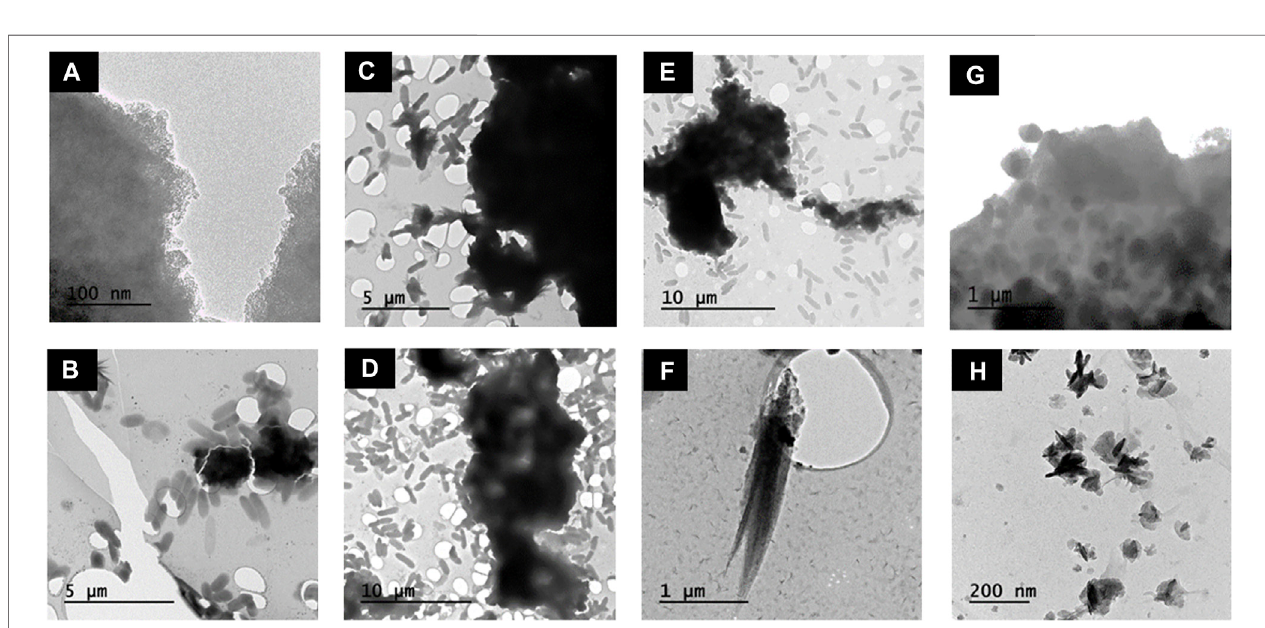
FIGURE 3 | TEM images of Co-doped ferrihydrite suspension associated with G. sulfurreducens and changes in mineral morphology over time. (A,B) 1 h; (C,D) 9 h; (E – F) 20 h; (G – H) 72 h.